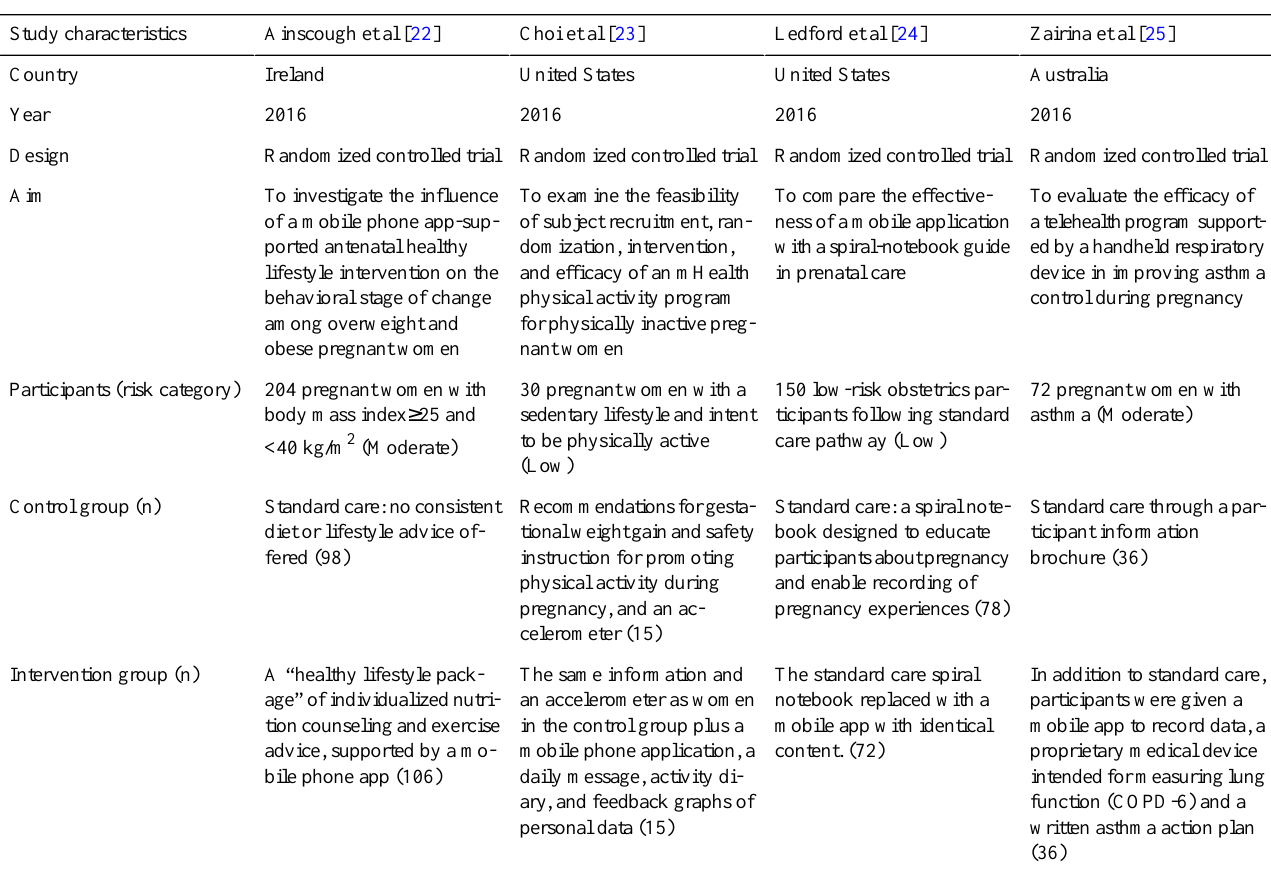
Table 2. The characteristics of included